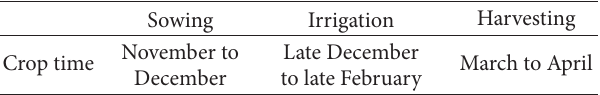
Table 2: Ranges and linguistic value of the input variable cropping time.